Question: Write a single sentence explaining what this figure depicts.
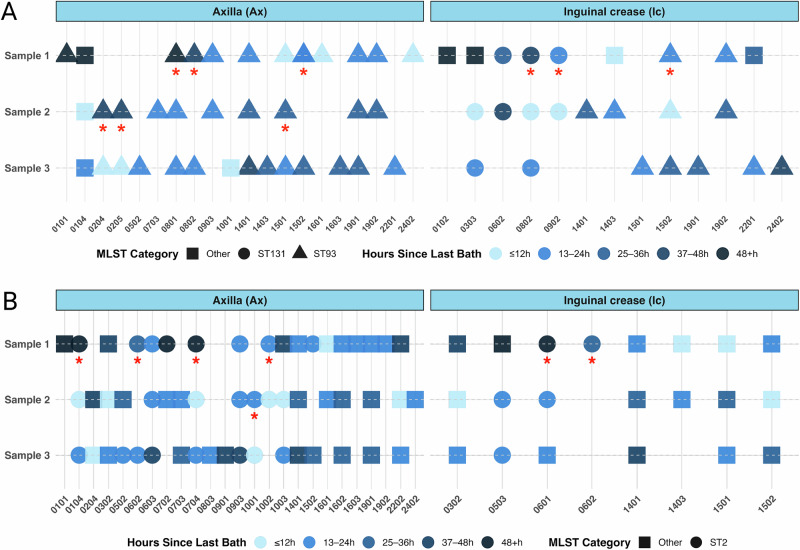
Answer: Persistent colonization of NH residents’ skin post-bathing. A Persistent recovery of E. coli ST131 and ST93 MAGs before and after bathing, stratified by body site (axilla [Ax] and inguinal crease [Ic]) and organized by resident. Shape represents STs, with the color indicating time since last bath ranging from 12 h (lighter) to 48 h (darker). The x-axis lists NH residents, and the y -axis indicates sampling events. Red asterisk (*) indicates when bathing occurred between sampling and is only applied for ST131 and ST93. Gaps represent no E. coli MAG detected. B Persistent recovery of S. epidermidis ST2 MAGs before and after bathing, stratified by body site (axilla [Ax] and inguinal crease [Ic]) and organized by resident. Each tile represents a sample; colored circles indicate recovery of an S. epidermidis ST2 MAG and are colored by time since last bath. Red asterisks mark persistent detection of S. epidermidis ST2 across multiple timepoints in the same resident. In the facet “Inguinal Crease” for resident 0602 there is an asterisk but no isolate indicated for Sample 2 or 3 because the individual had a bath and a subsequent MAG but this MAG did not meet the genomic criterion for completeness. Figure panels were assembled using Biorender under publication license, Segre, J. (2026) https://BioRender.com/eo9rqi6 .